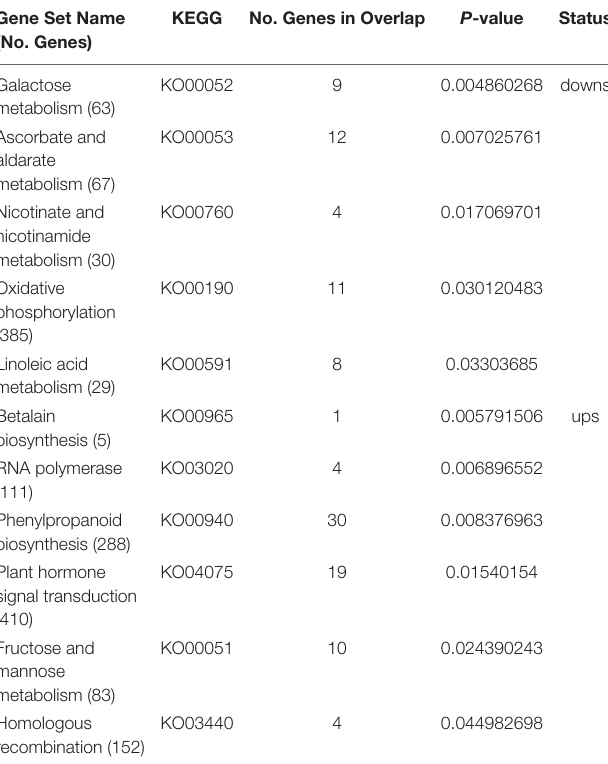
TABLE 3 | Enriched gene sets in genes up-regulated and down-regulated in SlTPL1RNAi during fruit set process by